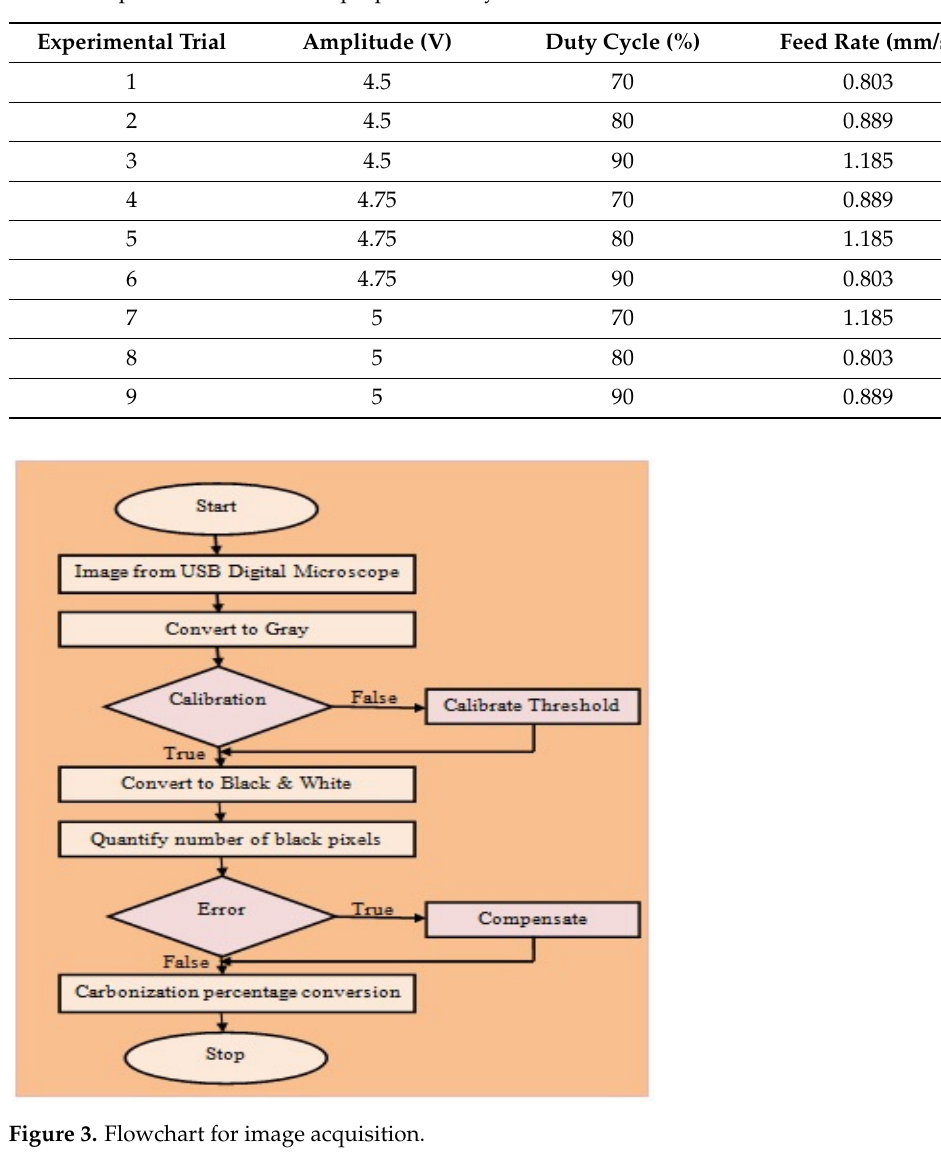
Table 2. Experimental trial in the proposed study.